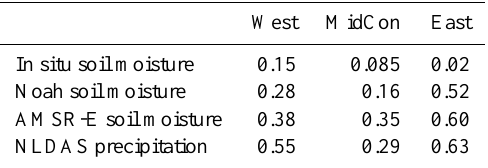
Table 4. Slopes of linear relationship between log-(spatial variabil- ity of soil moisture and precipitation) and log-(extent) in each cli- mate region. NLDAS precipitation (mm) was calculated using val- ues at SCAN locations